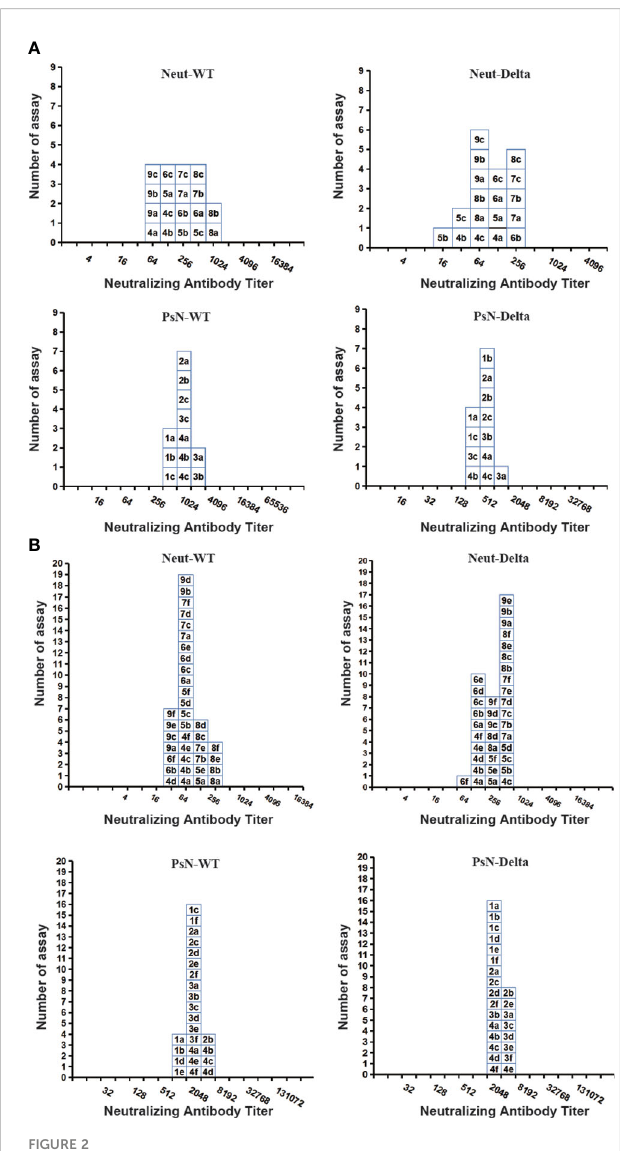
FIGURE 2 Histograms showing the distribution of the endpoint titer (ID 50 ) for two candidate national standards (samples 33 and 66 – 99) across laboratories. (A) Sample 33, (B) Samples 66 – 99. Each box represents the endpoint titer for each assay, labelled with the laboratory code number (1 – 9), and followed by one independent assay (a – f), indicating the assays. The live virus neutralization assay (Neut) and pseudovirus neutralization assay (PsN) results using the wild-type (WT) strain or Delta variant are shown side by